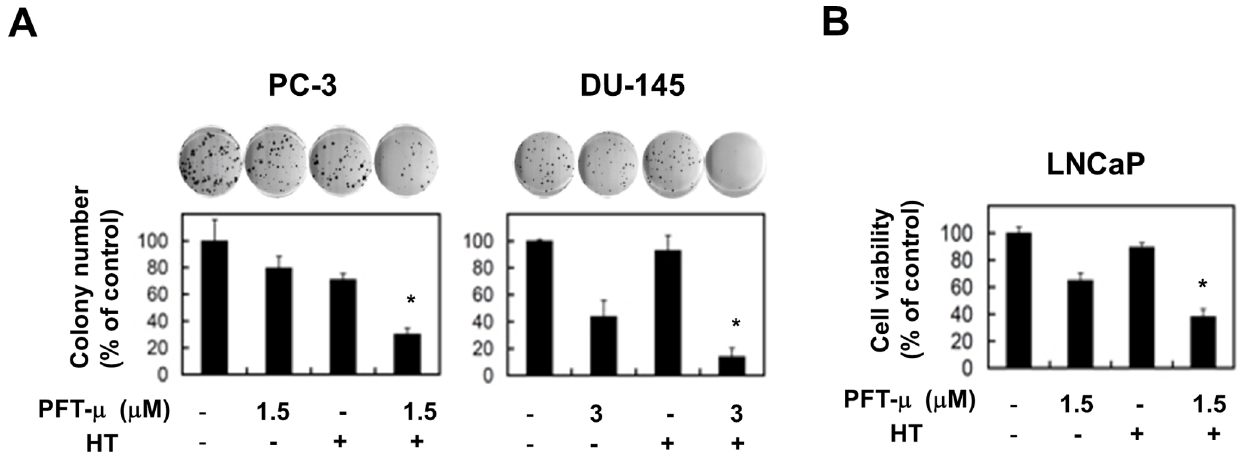
Figure 6. Combination therapy with HT and PFT- m decreased the colony-forming ability of cancer cells. ( A ) PC-3 and DU-145 cells were cultured for 14 days and their colony-formation capacities were determined. The results are shown as the mean 6 SD of three wells. * P , 0.05 (Student’s t -test) ( B ) LNCaP cells were cultured for 12 days, and viability (%) was determined using the WST-8 assay. The results are shown as the mean 6 SD of three wells. * P , 0.05 (Student’s t